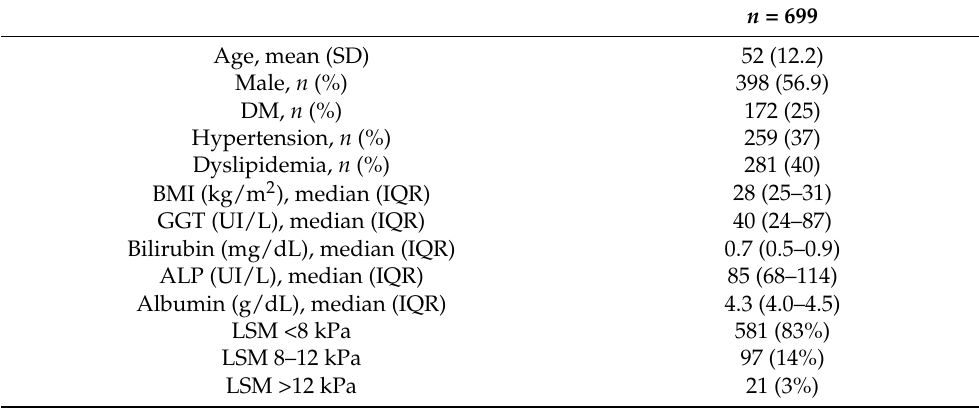
Table 2. Distribution of selected characteristics * of 699 NAFLD patients with FIB-4 <